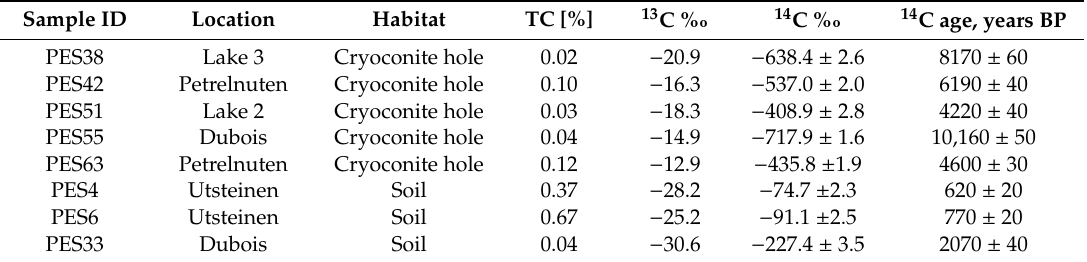
Table 2. Overview of all 13 C and 14 C data of the cryoconite hole and soil samples and the corresponding ages of the carbon.